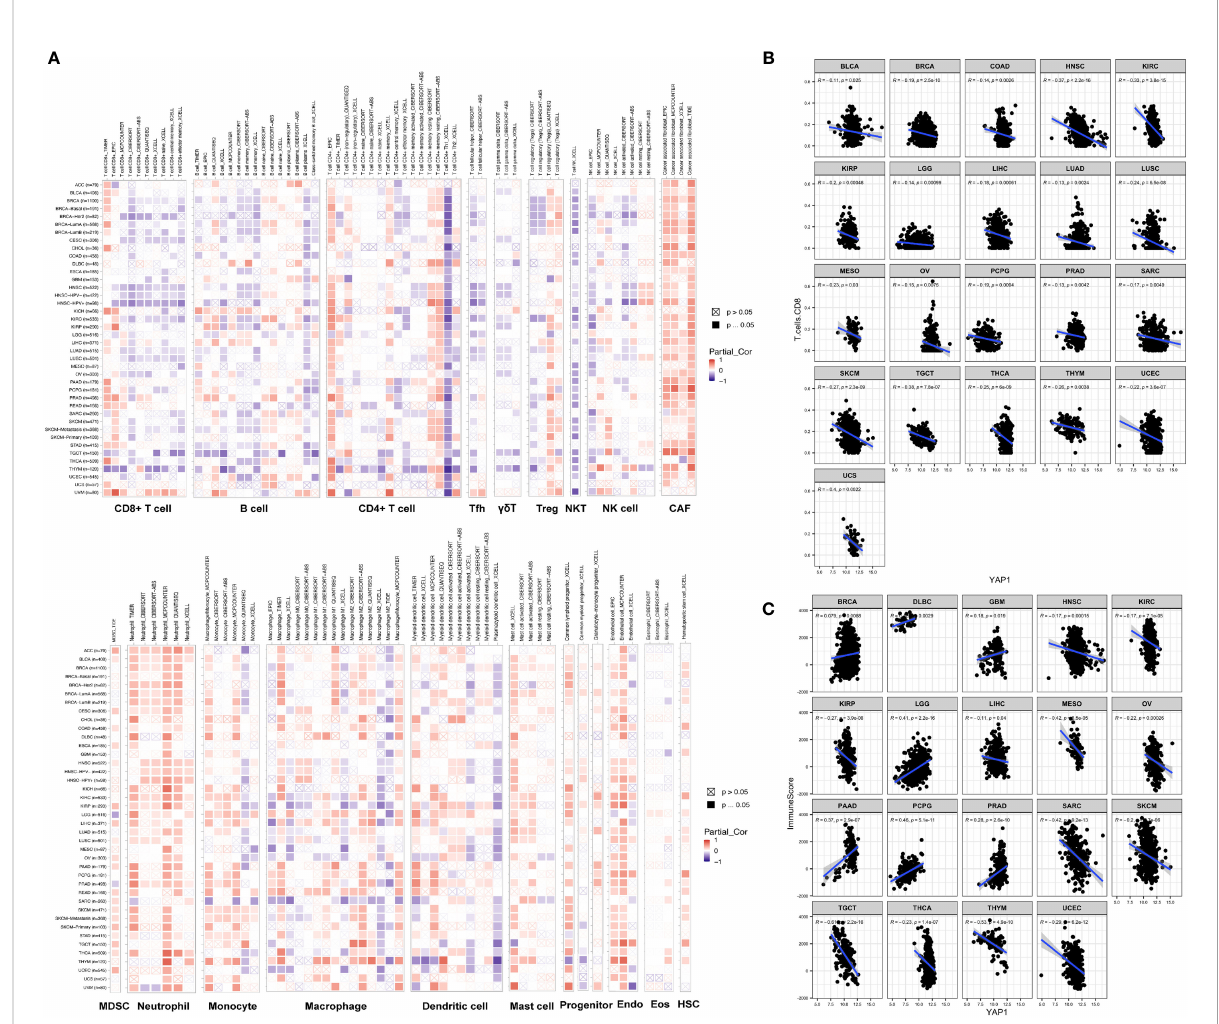
FIGURE 4 Correlation of YAP1 expression with immune cell in fi ltration. (A) Pearson correlation between YAP1 expression and in fi ltration of 22 immune cell types using different programs. Positive correlation is in red and negative correlation is in blue. * p < 0.05. (B) Pearson correlation between YAP1 expression and in fi ltration of CD8+ T cells in pan-cancer. Only statistically signi fi cant cancer types were shown. (C) Pearson correlation between YAP1 expression and immune score. Only statistically signi fi cant cancer types were shown. Tfh, T follicular helper cells. Treg, regulatory T cells; NKT, natural killer T cells; NK, natural killer cells; CAF, cancer-associated fi broblast; MDSC, myeloid-derived suppressor cell; Endo, endothelial cell; Eos, eosinophil; HSC, hematopoietic stem cell. gd T cells, gamma-delta T